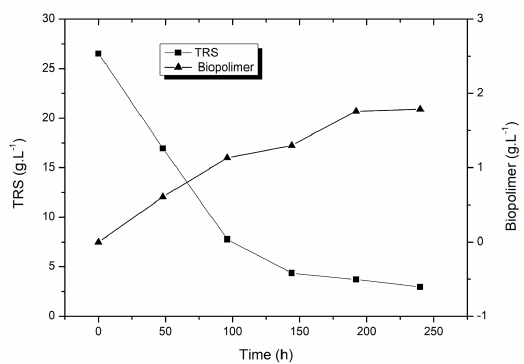
Figure 2. Kinetic curves based at the concentration of total reducing sugars for the culture medium (A).